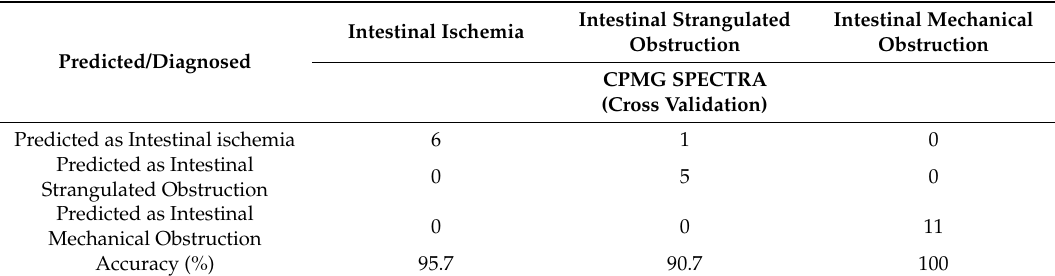
Table 3. Cross-Validation results (confusion matrices) and accuracies from the OPLS-DA analysis of the CPMG NMR spectra for intestinal ischemia, strangulated obstruction, and mechanical